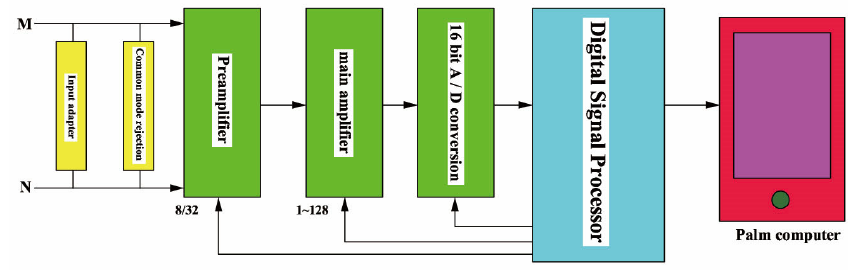
Figure 3. Principle block diagram of receiver.